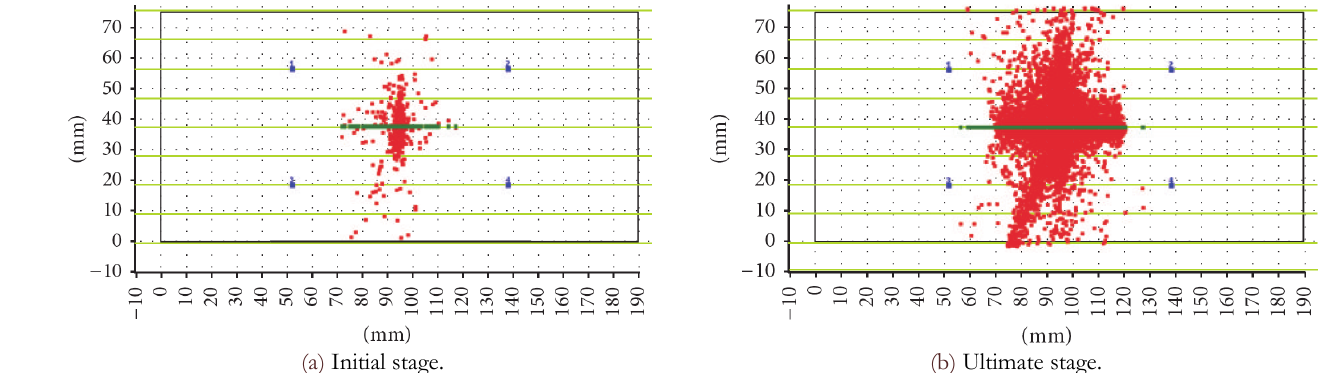
Figure 6: AE locations on rock plate.